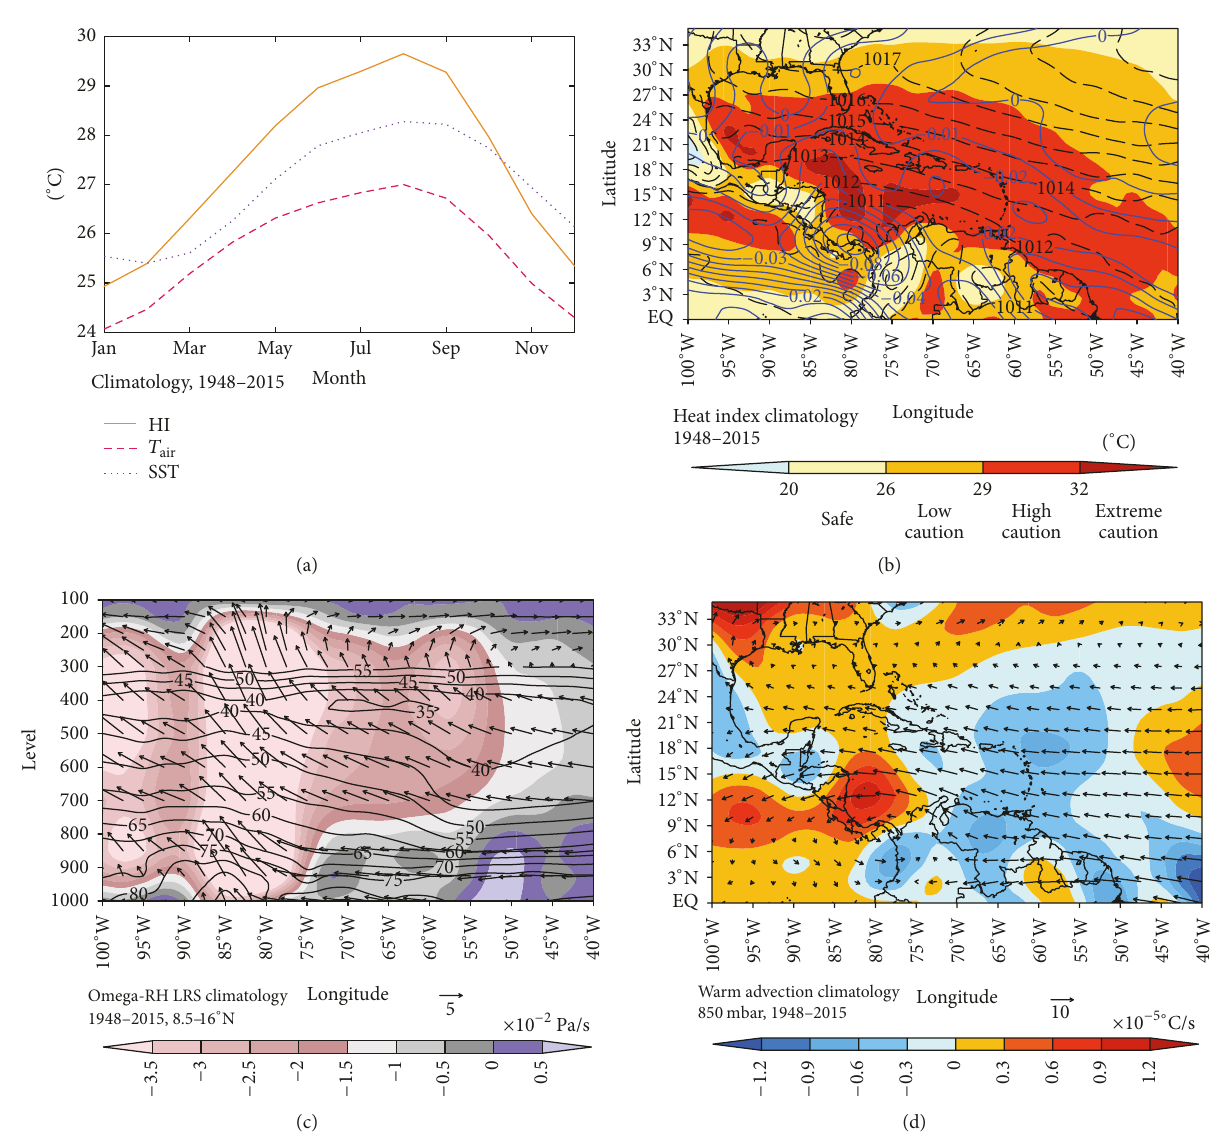
Figure 2: IAR climatology for (a) SST, air temperature, and HI. (b) Heat index in ∘ C (color shades), SLP in mbar (dotted black contour line), vertical velocity in Pa/s (blue contour line) in the LRS, (c) vertical velocity in color shades ( × 10 −2 Pa/s), relative humidity in % (black contour line), and wind vector in the LRS. (d) Warm/cold advection in color shades ( × 10 −5∘ C/s) and wind vector at 850 mbar in the LRS.